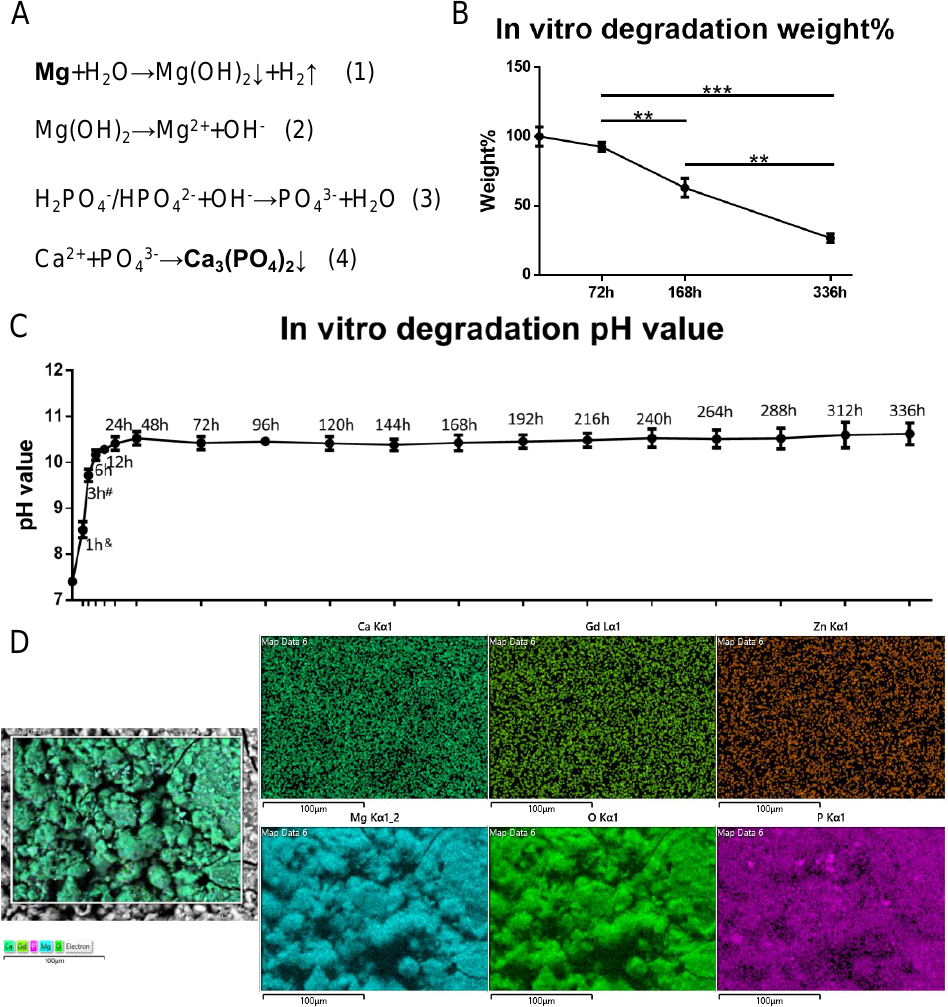
Figure 2. The in vitro degradation. ( A ) Chemical reaction during degradation process; ( B ) weight changing curve during 336 h immersion, n = 3, one-way AONVA, Tukey test, ** p < 0.01, *** p < 0.001; ( C ). pH value changing curve during 336 h immersion, &: significantly different in each group, #: significantly different for 1 h, 6 h to 120 h, n = 3, one-way AONVA, Tukey test, p < 0.05; ( D ). SEM/EDS detection on the corrosion interface (72 h immersion).